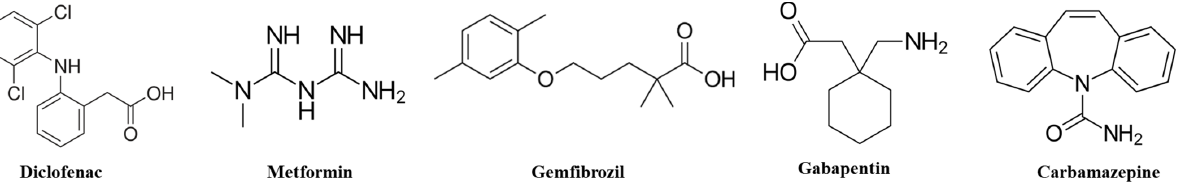
Figure 4. Pharmaceutical compounds used in this